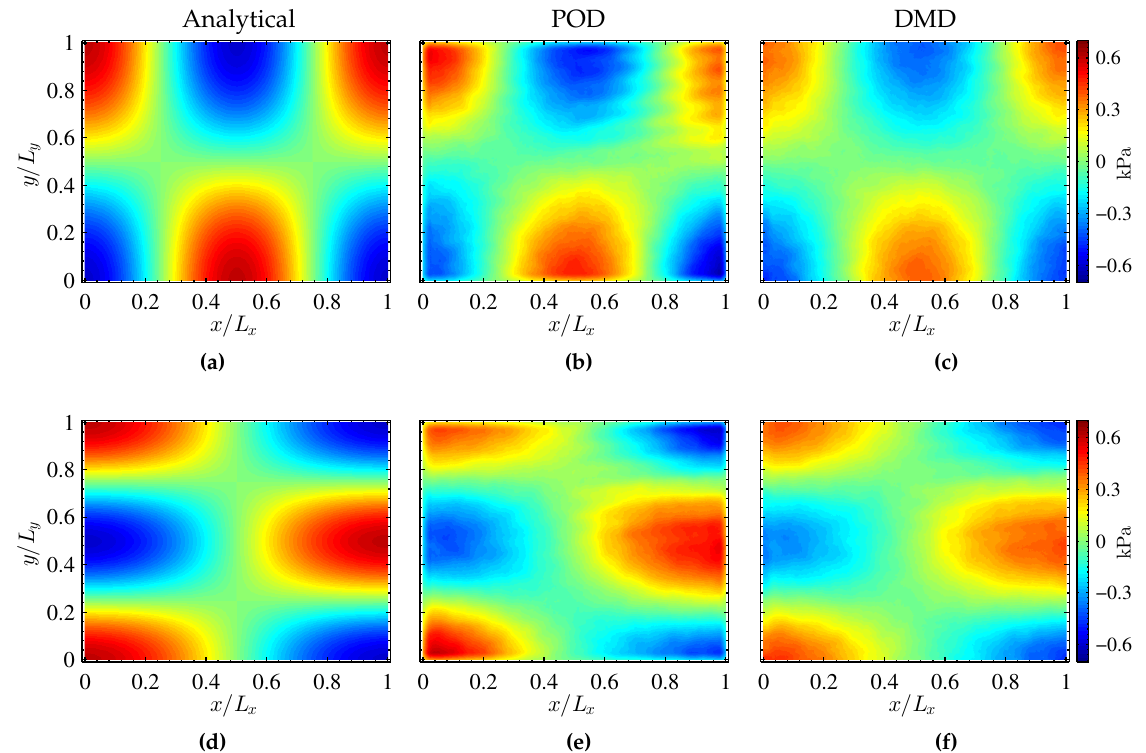
Figure 9. Comparison of decomposed mode shapes ( 2,1,0 ) ( Top row) and ( 1,2,0 ) ( Bottom